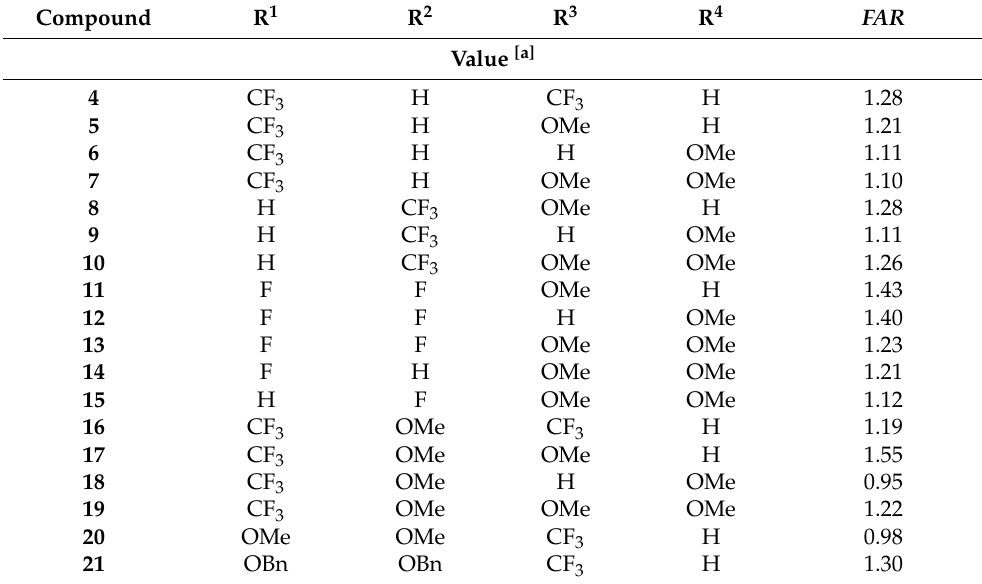
Table 1. MRP4 inhibition data of target compounds 4 – 21 with varied substitution patterns expressed as FAR